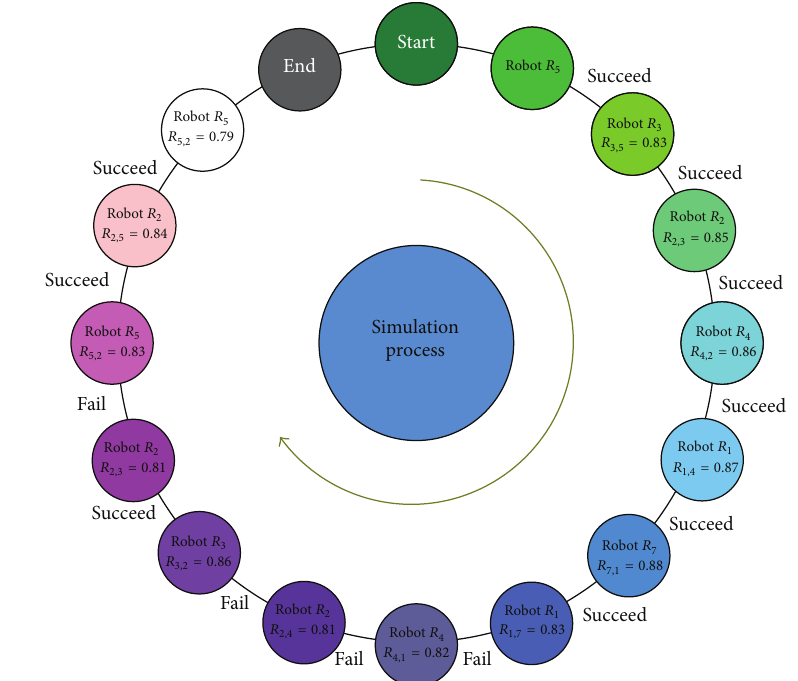
Figure 7: Process of task allocation by